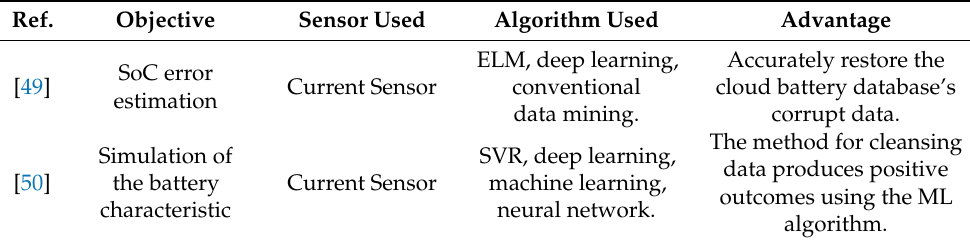
Table 5. A detailed survey on big data in battery-management systems.